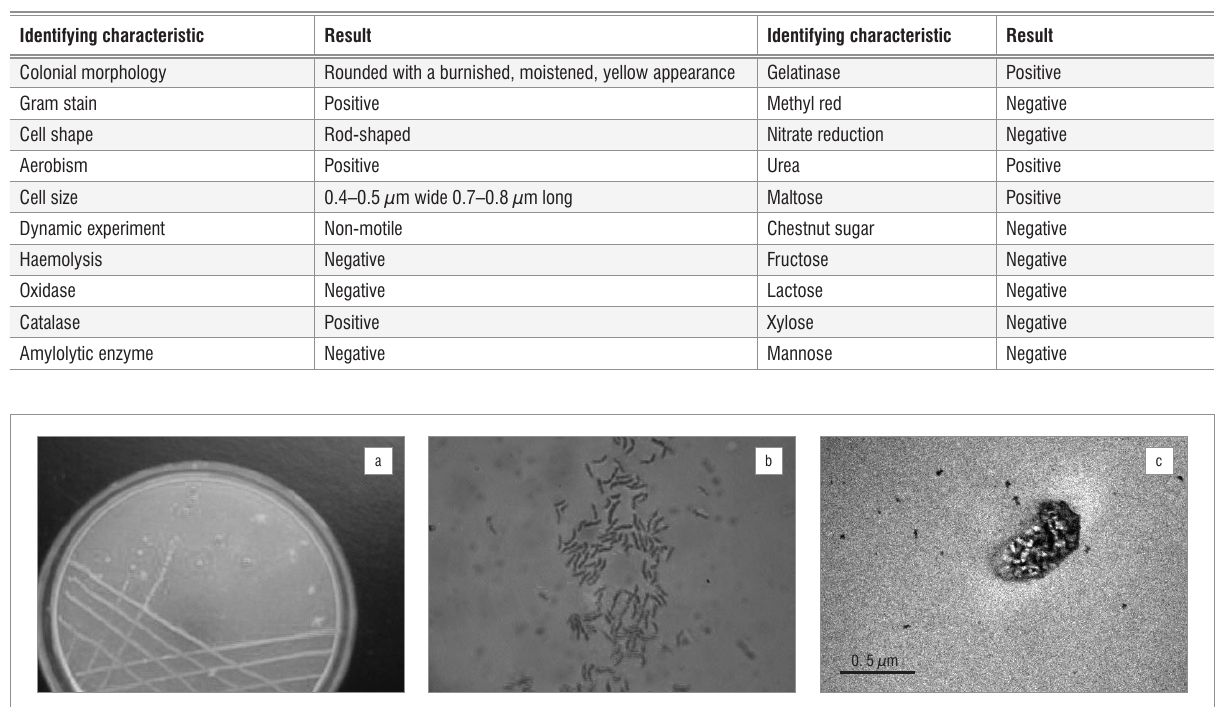
Characteristics of Arthrobacter sp.0574